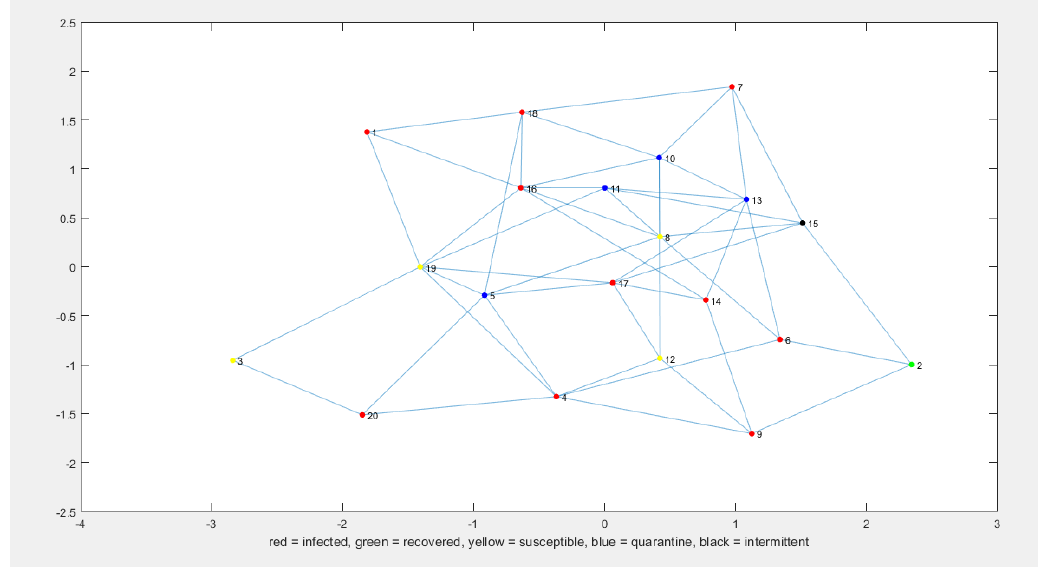
Figure 10. Node-state graph at time t =